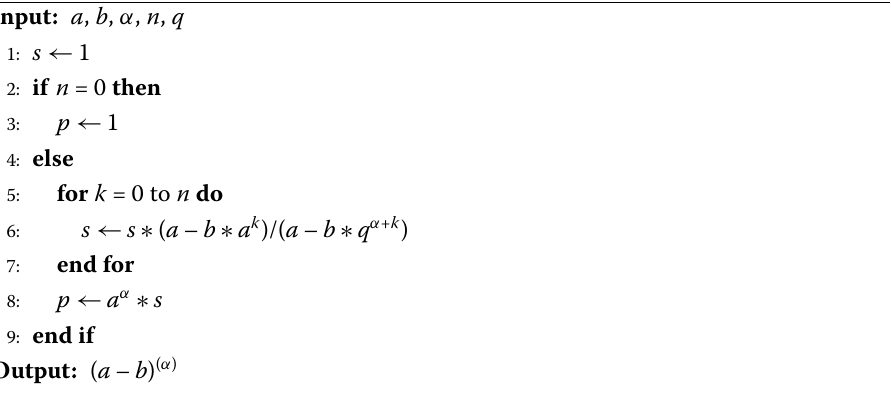
Algorithm 1 The proposed method for calculating ( a – b ) ( α ) q